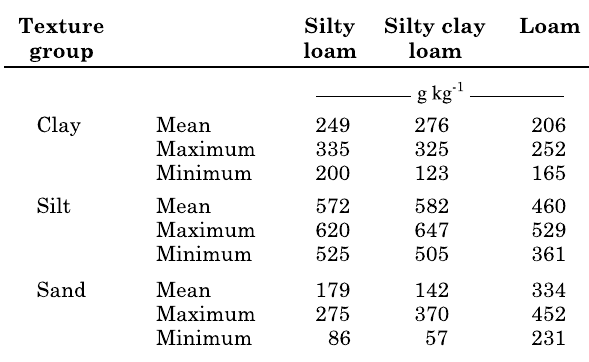
Table 1. Clay, silt and sand content of the studied soils of the different texture groups (0–30 cm)